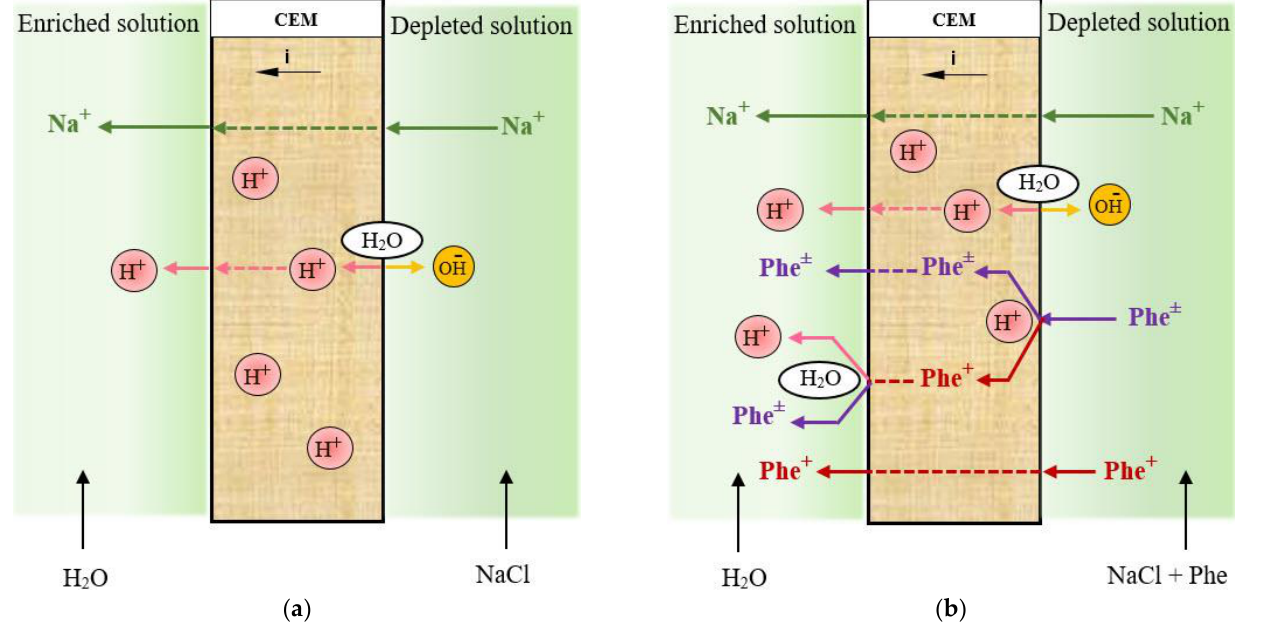
Figure 8. A schematic representation of ion transport, water splitting and aside dissociation phenomena in the systems CEM/NaCl solution ( a ) and CEM/NaCl+Phe solution ( b ).